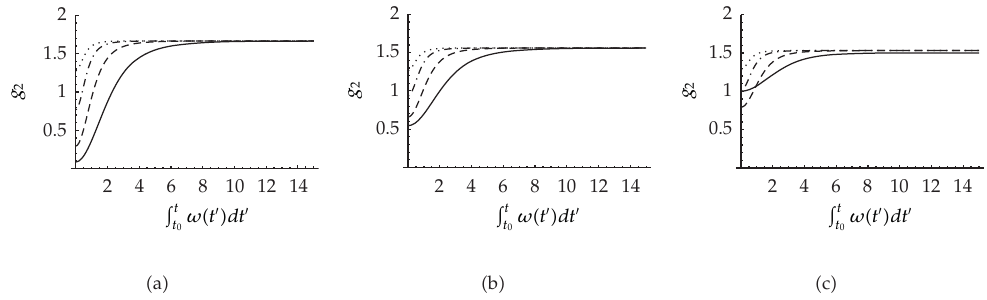
Figure 4: Second-order correlation functions evaluated over (cid:4) a (cid:5) the n (cid:8) 1, (cid:4) b (cid:5) the n (cid:8) 2, and (cid:4) c (cid:5) the n (cid:8) 50 harmonic oscillator eigenstate that results from the instantaneous Hamiltonian spectral problem at t 0 . In all figures: δ 0 (cid:8) 0 . 2 , 0 . 4 , 0 . 8 , 1 . 6 (cid:4) solid, dashed, dot-dashed, dotted (cid:5)